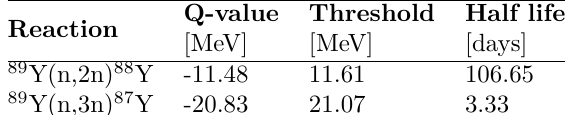
Figure 7. Spectral neutron flux measured by the PRT method with the CLID.